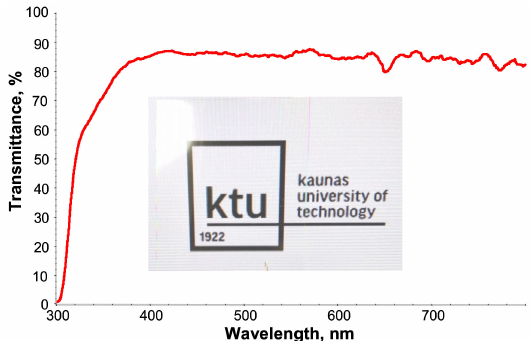
Figure 4. UV-vis spectrum and digital photo of PETMP-TTT coating on PET substrate over KTU logo, displayed through a computer monitor.